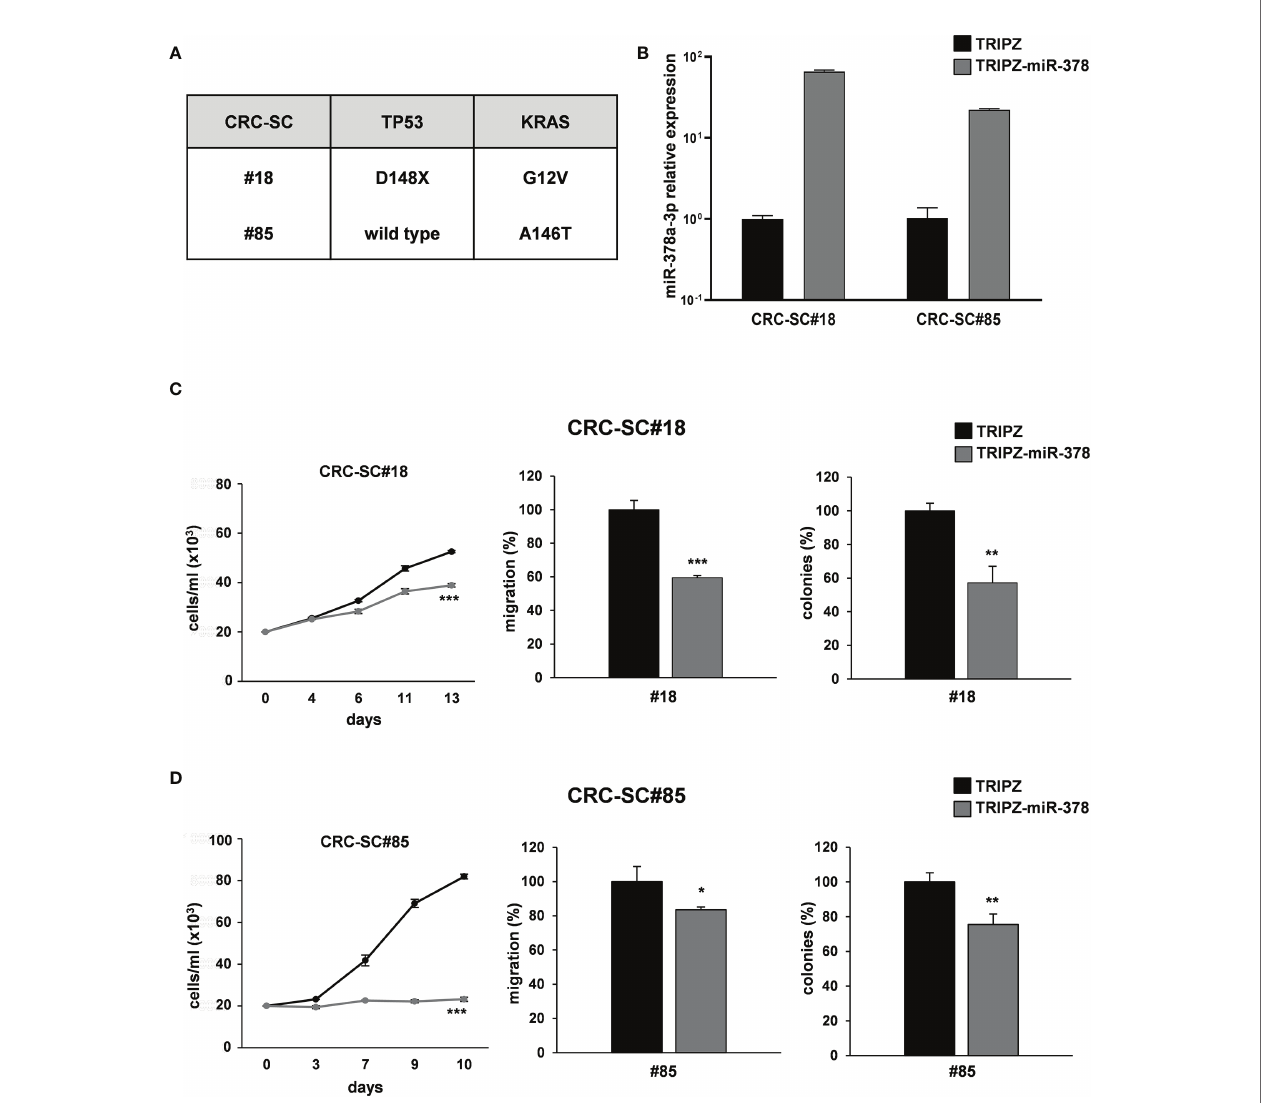
FIGURE 3 | miR-378a-3p restoration reduces cell growth, migration and clonogenic abilities of patient-derived CRC-SCs. (A) Mutation status of CRC critical genes in patient-derived CRC-SCs (#18 and #85). (B) MiR-378a-3p expression was analyzed by qRT-PCR in CRC-SC#18 and CRC-SC#85 transduced with TRIPZ or TRIPZ-miR-378 inducible vectors after doxycycline exposure. Functional in vitro assays on (C) CRC-SC#18 and (D) CRC-SC#85 transduced with TRIPZ or TRIPZ- miR-378 vector. Growth curves of CRC-SCs ( left panels ). Points and range lines at each day represent mean ± SD of at least two independent experiments in triplicate. Migration assay of CRC-SCs transduced with TRIPZ or TRIPZ-miR-378 vector ( center panels ). Values are reported as percentage relative to TRIPZ vector and shown as mean ± SD from two independent experiments in triplicate. Colony formation assay of CRC-SCs transduced with TRIPZ or TRIPZ-miR-378 vector ( right panels ). Percent colony number values from two independent experiments in triplicate were calculated over the correspondent TRIPZ vector and are shown as mean ± SD for each CRC-SC line. *p<0.05; **p<0.01; ***p<0.001 based on Student ’ s t